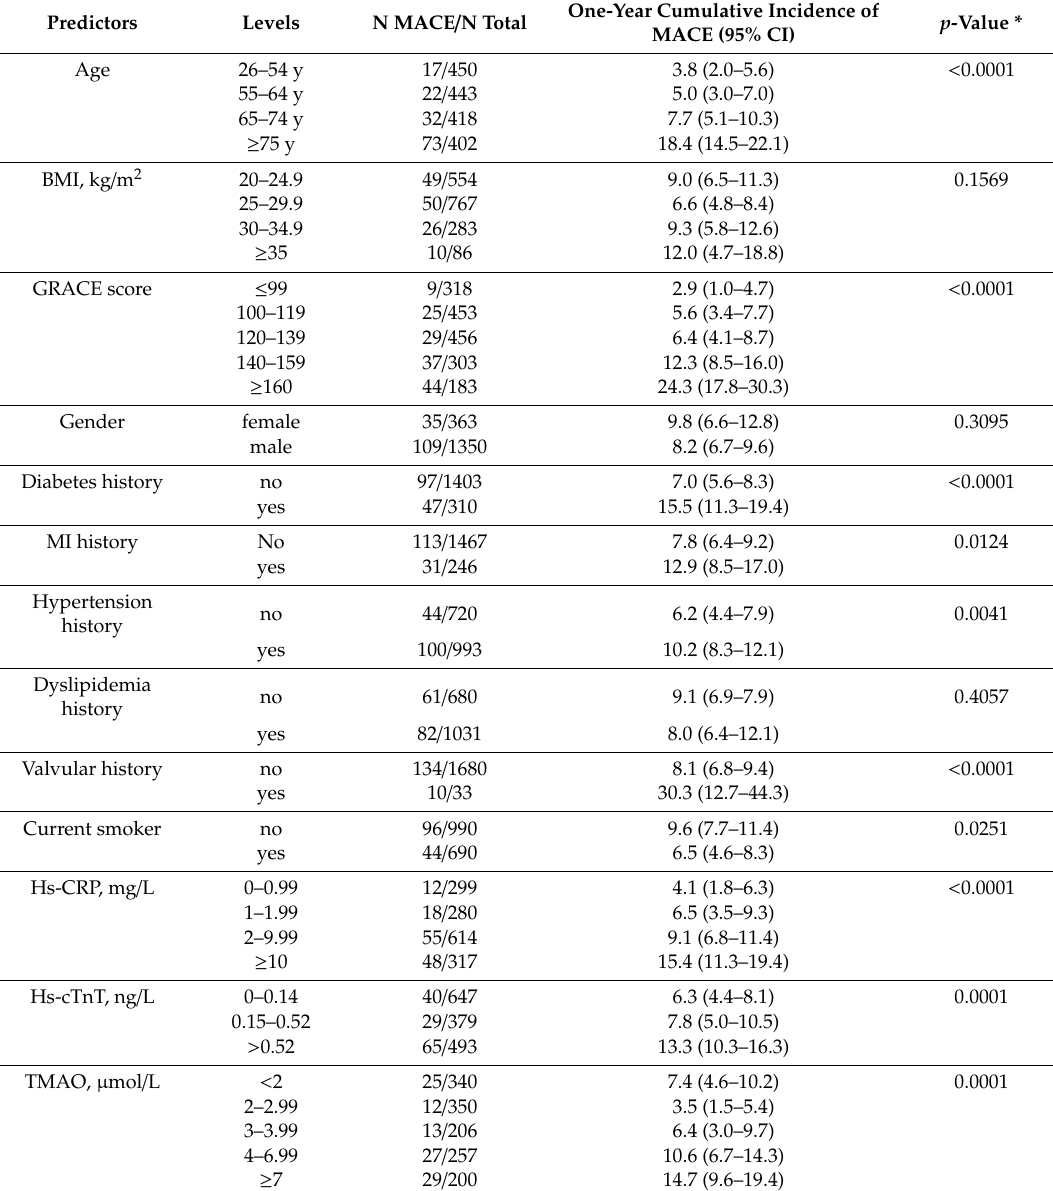
Table 2. One-year cumulative major adverse cardiovascular events (MACE) incidence according to univariate